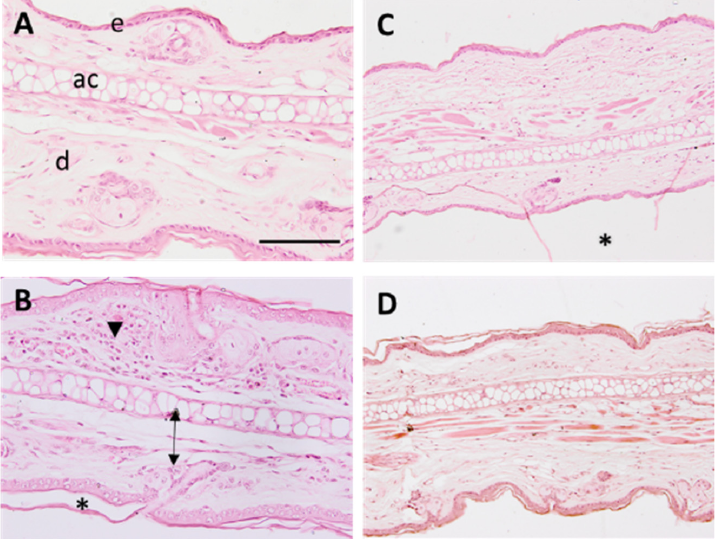
Figure 3. Micrographs of mouse ear samples (×100 magnification). ( A ) Negative control, ( B ) positive control, ( C ) reference drug (ibuprofen gel), and ( D ) treatment with D. peruviana EO. Scale bar = 200 µM. e: epidermis, d: dermis, ac: auricular cartilage. Arrowhead indicates neutrophilic infiltrates, arrows show edema, and asterisks indicate stratum corneum loss.